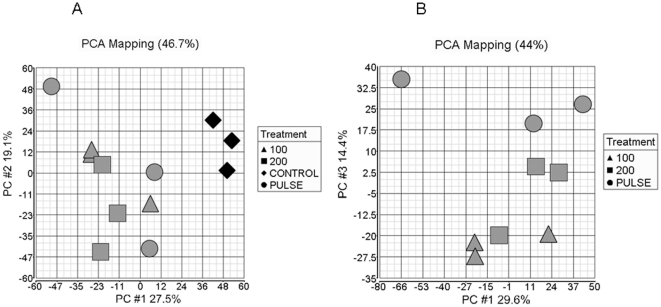
Microarray analysis of the transcriptome response to pulsatile versus continuous glucocorticoid treatment.(A) Principal components analysis (PCA) of microarray data to establish relationships between the samples using all genes in the microarray dataset. Control, pulsatile cortisol delivery (PULSE), continuous 100 ng/ml (100), and continuous 200 ng/ml (200) are indicated on the plots. There is a clear separation between all the cortisol treatments and control in the first component. (B) When cortisol treatments are considered separately pulsatile treatment segregates from the two continuous treatments in the third component.